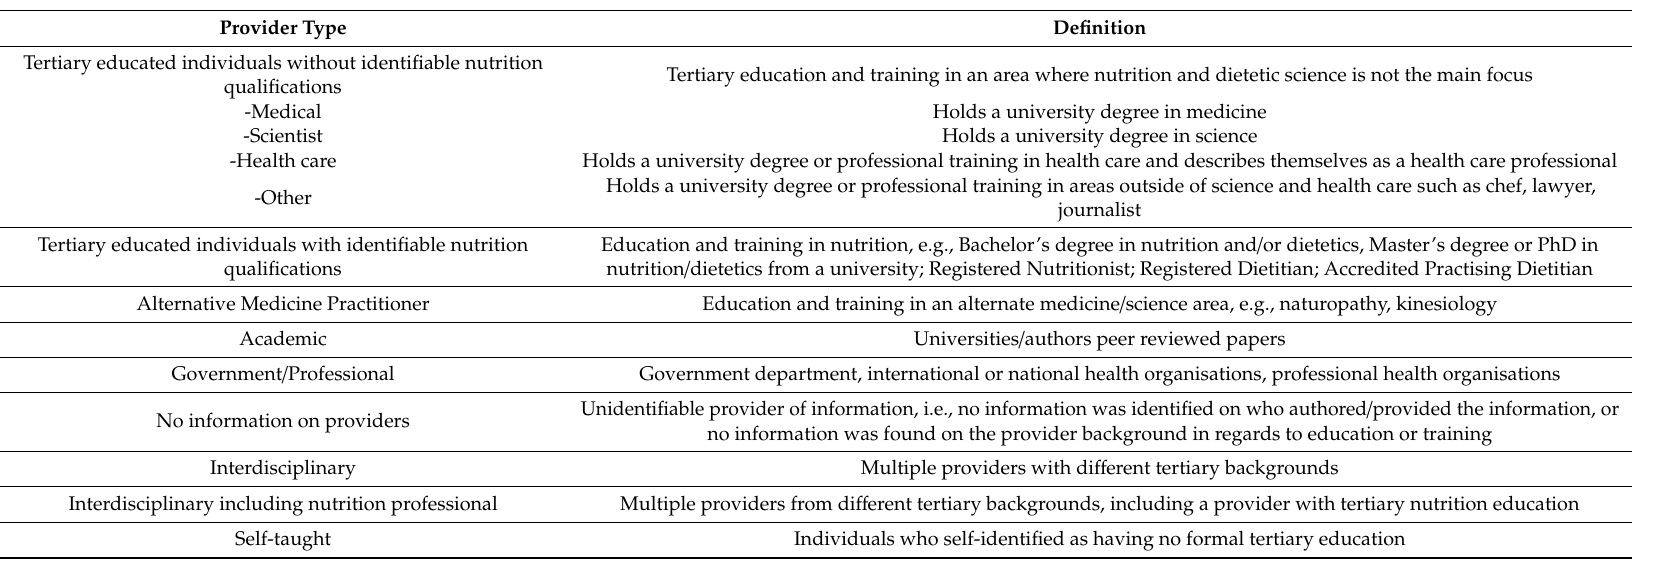
Table A2. Classification framework of vocational background of